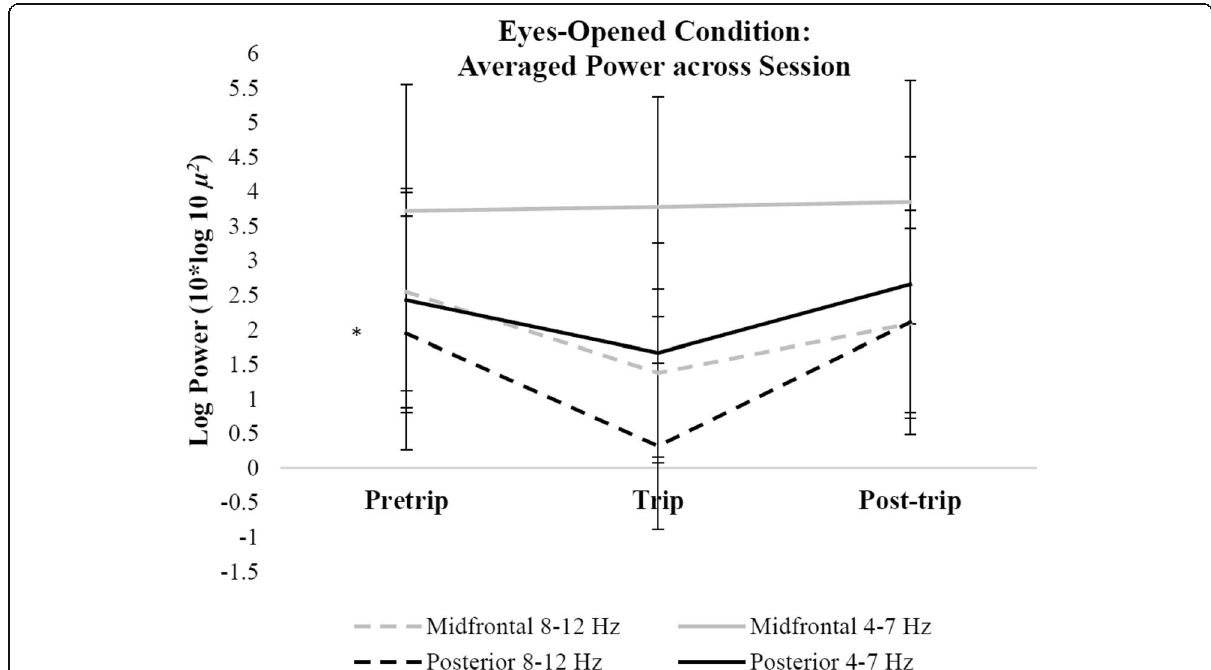
Fig. 2 Changes in log transformed power across sessions during the eyes-opened condition. Error bars indicate 95% confidence intervals around the mean. * p < 0.01